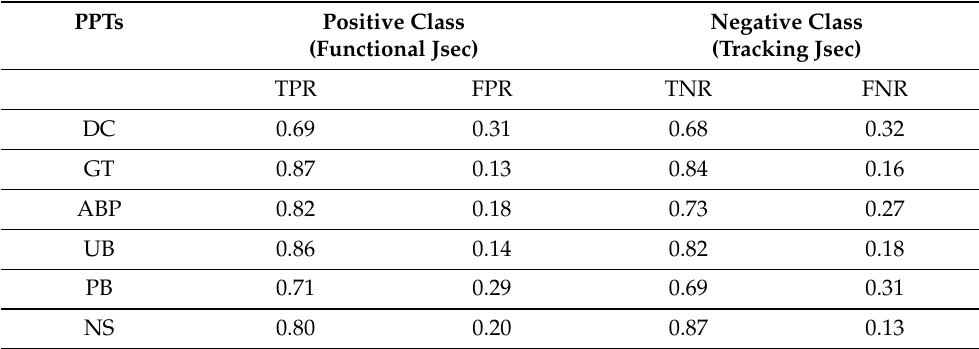
Table 5. Comparison of the PPTs with our labeled dataset between allow and block functional (TP, FP), and allow and block tracking (FN, TN). PPTs Positive Class Negative Class (Functional Jsec) (Tracking Jsec)